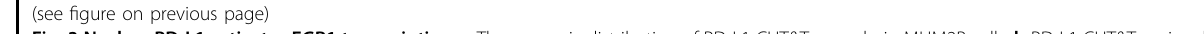
Fig. 3 Nuclear PD-L1 activates EGR1 transcription. a The genomic distribution of PD-L1 CUT&Tag peaks in MUM2B cells. b PD-L1 CUT&Tag signal height and position relative to transcription start sites (TSSs) for all genes in MUM2B cells. Two replicates are shown. c CUT&Tag density heatmap of PD-L1 enrichment in MUM2B cells within 3 kb around TSS. d Bioinformatics analysis identi fi ed EGR1 as a downstream target of nPD-L1. e Correlation plot of EGR1 expression and angiogenesis GSVA score in the TCGA-UM cohort. Correlation coef fi cients were calculated by the Spearman test. f IGV tracks for EGR1 from PD-L1 CUT&Tag analysis. g IGV tracks for EGR1 expression from RNA-seq analysis of PD-L1-silenced cells and control cells. h , i ChIP-qPCR assay of the PD-L1 status at the EGR1 promoter and its upstream and downstream regions after PD-L1 silencing in MUM2B ( h ) and MEL290 ( i ) cells. j Western blot images showing the protein levels of EGR1 and VEGFA in PD-L1-silenced cells and control cells. k IF images of EGR1 in UM orthotopic xenografts. Scale bars, 50 µm. l Statistical analysis of EGR1 expression in UM orthotopic xenografts. n = 5. Data are presented as means ± SD. Two-tailed unpaired Student ’ s t